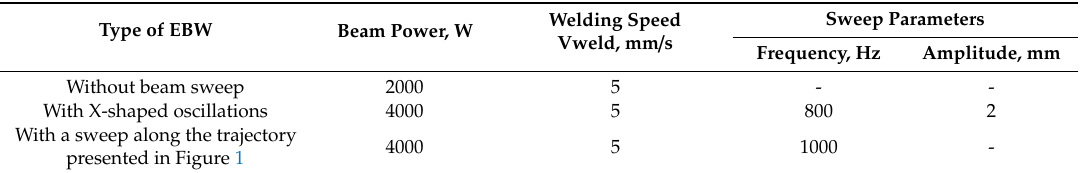
Table 2. EBW parameters for the 20Cr3MoWV steel